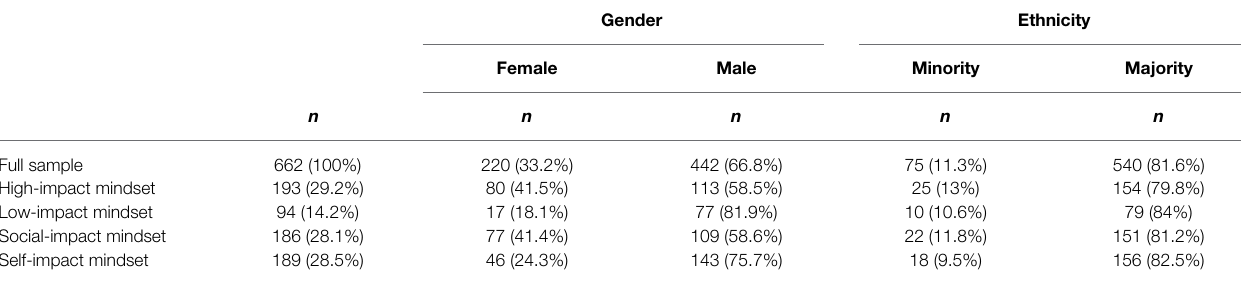
TABLE 2 | Student distribution by sample, motivational mindsets, gender, and ethnic subgroups.